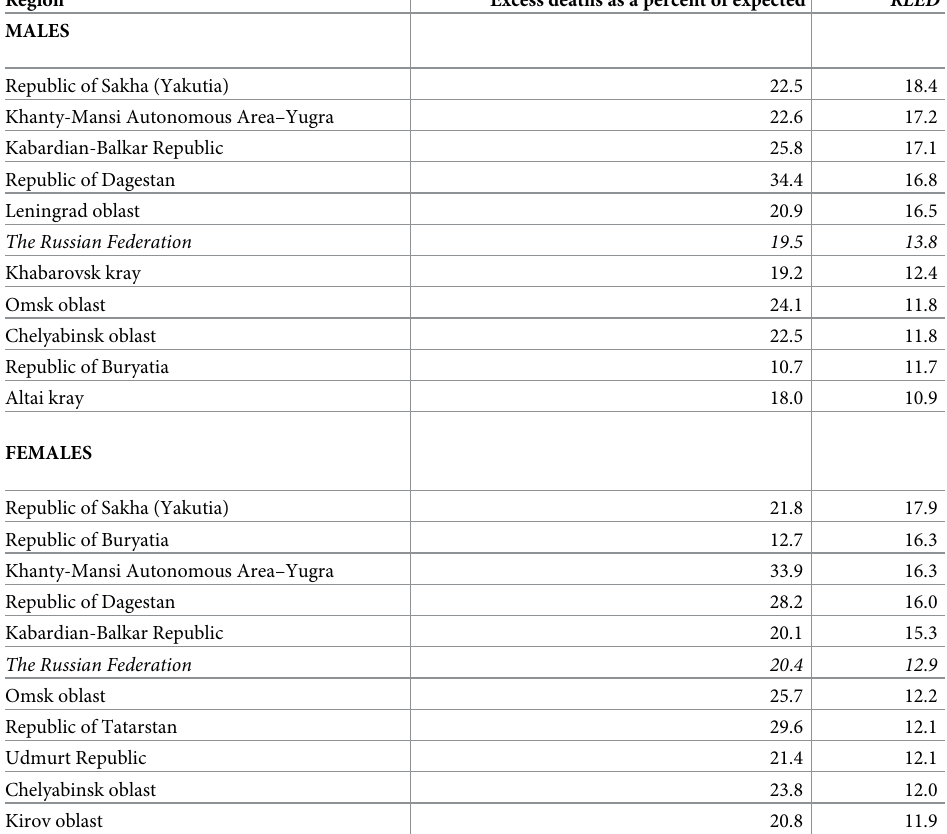
Table 4. Remaining life expectancy of the deceased, RLED, in regions of the Russian Federation with greater than 3,000 predicted deaths per year, 2020, males and females.